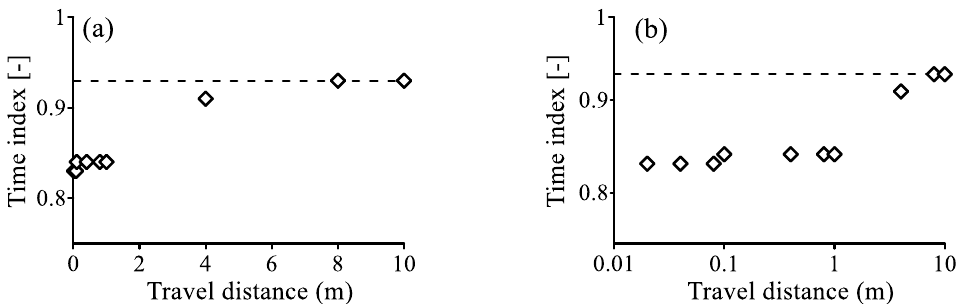
Figure 6. Fracture: The change of the time index γ in the FADE (7a) with the travel distance for fitting the Breakthrough curves (BTCs) shown in Figure 5. The dashed line shows the asymptote. ( b ) is the semi-log plot of ( a ).